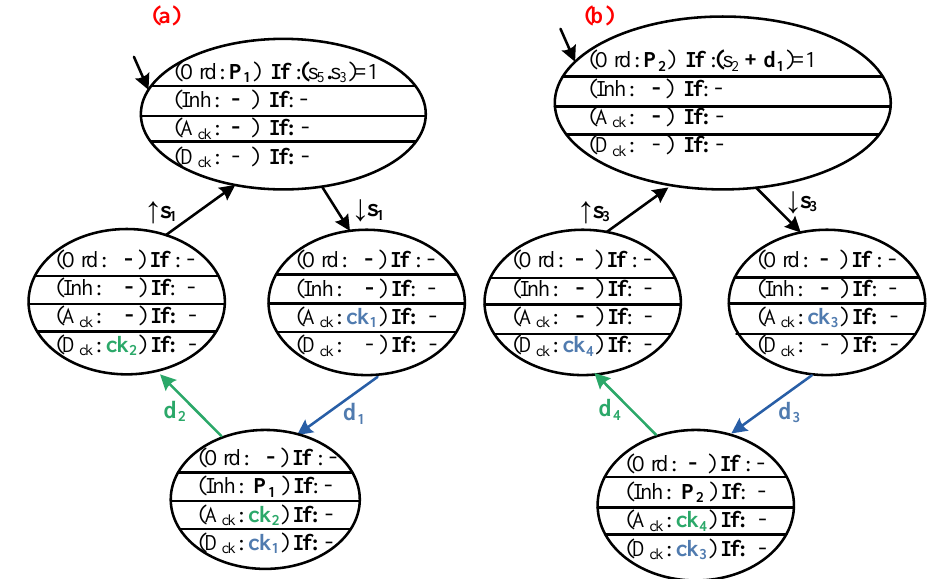
Figure 13. Distributed controllers of degraded behavior of ( a ) P1, ( b ) P2.